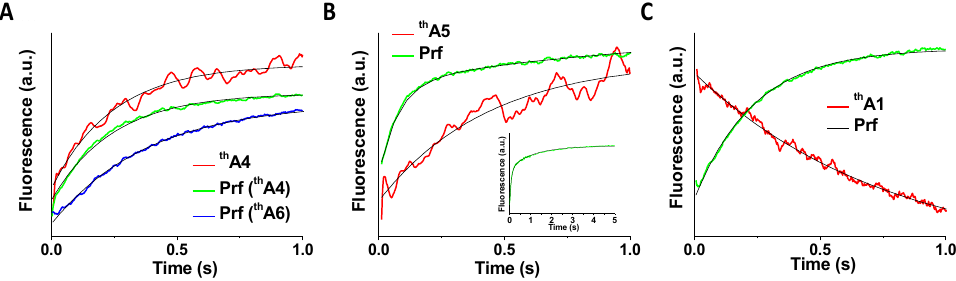
Figure 5. Kinetics of POST complex formation of th A-containing mRNAs. Fluorescence changes on rapid mixing of PRE complexes (0.1 mM) programmed with th A-containing mRNAs (black) and EF-G.GTP (2 mM) compared with fluorescence changes of fMetLys-tRNA Lys (prf) (red), present as part of the PRE complex. ( A ) th A4 and th A6; ( B ) th A5; ( C ) th A1. Solid black lines are exponential fits with k app as shown in Table 3. The inset in ( B ) shows an expanded time scale.